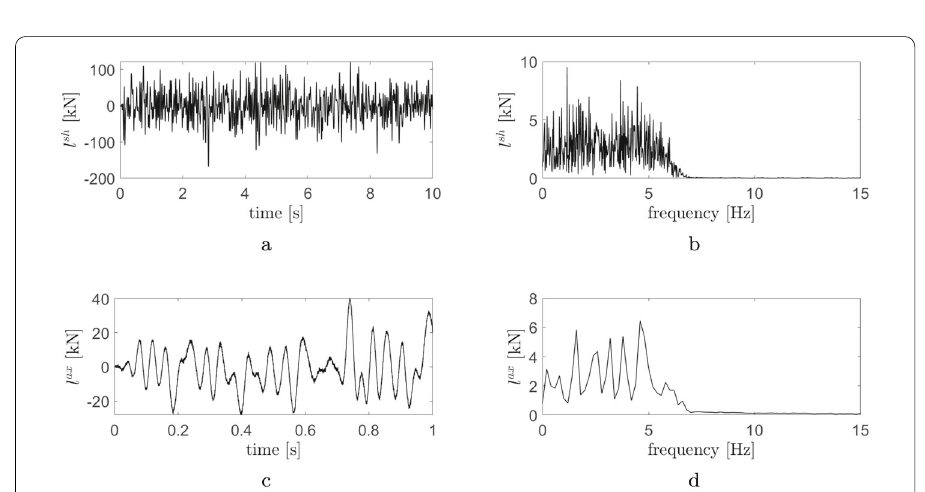
Fig. 12 White noise load case, f min = 5 and f min = 7 Hz. Time evolutions (left column) and Power Spectral Density (right column) of the forces enforced to all the building stories in x (first row) and z direction (second